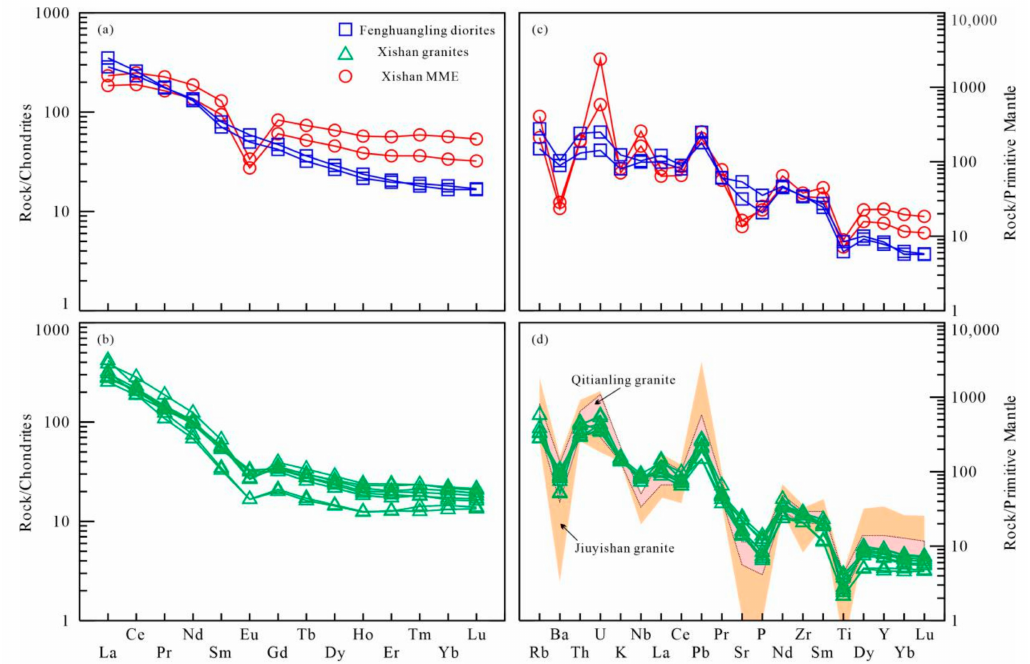
Figure 6. Chondrite-normalized REE patterns ( a , b ) and primitive mantle-normalized spider diagrams ( c , d ) for the Guiping complex. The chondrite and primitive mantle values are from [51]. Data source: